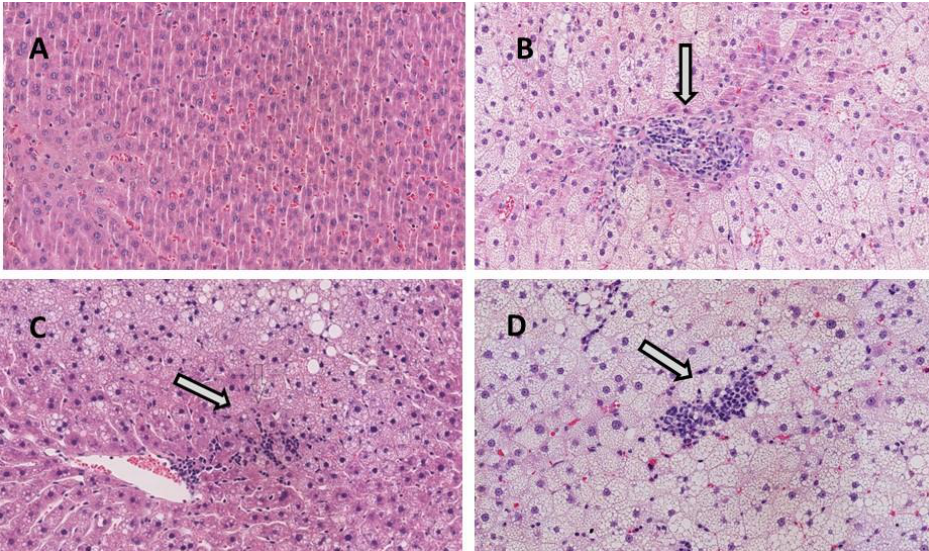
Figure 2. Representative H&E-stained histological liver samples (magnification ×20). ( A ) Healthy liver from CC group, ( B ) liver from HFHF group showing moderate inflammation and ballooning degeneration, ( C ) liver from PT30 group showing mild inflammation and ballooning degeneration and ( D ) liver from RSV30 group showing mild–moderate inflammation and ballooning degenera- tion. White arrows indicate inflammation. Ballooned cells are identified by the larger size of their wispy cleared cytoplasm.